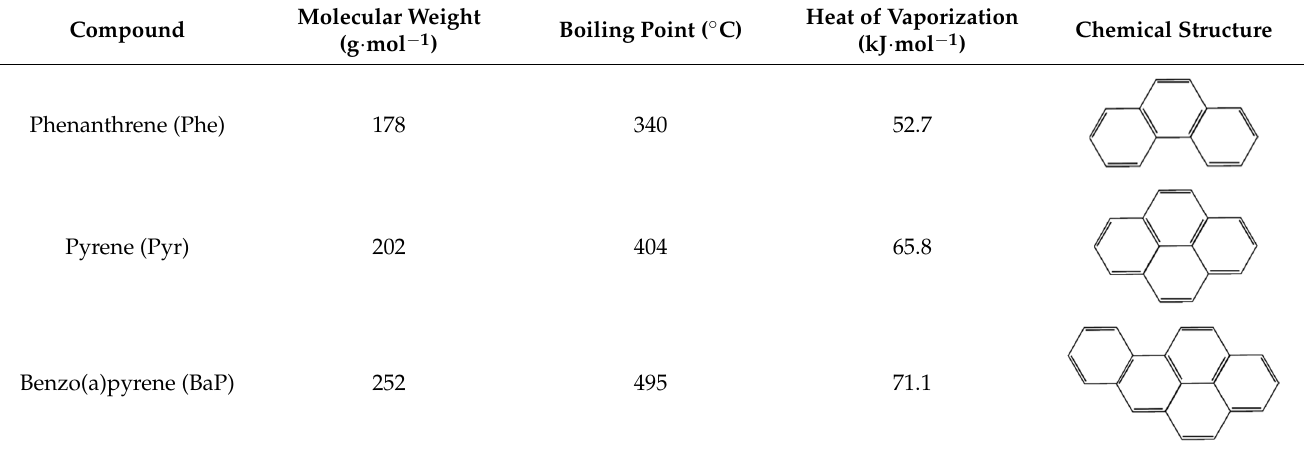
Table 2. Selected PAHs and their basic physical properties.